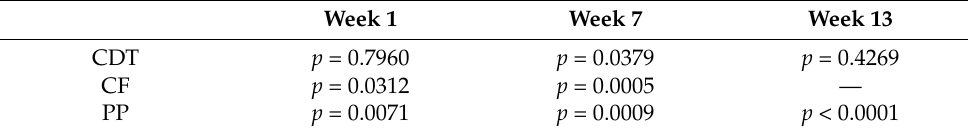
Table 4. Significance of correlation between headspace hexanal and oxidation flavor for cured deli turkey (CDT), chicken fillet (CF), and pulled pork (PP) after 1, 7, and 13 weeks of refrigerated stor- age. --- indicates that no measurements were done for CF at week 13. Significance of Correlation Between Hexanal and Oxidation Flavor Week 1 Week 7